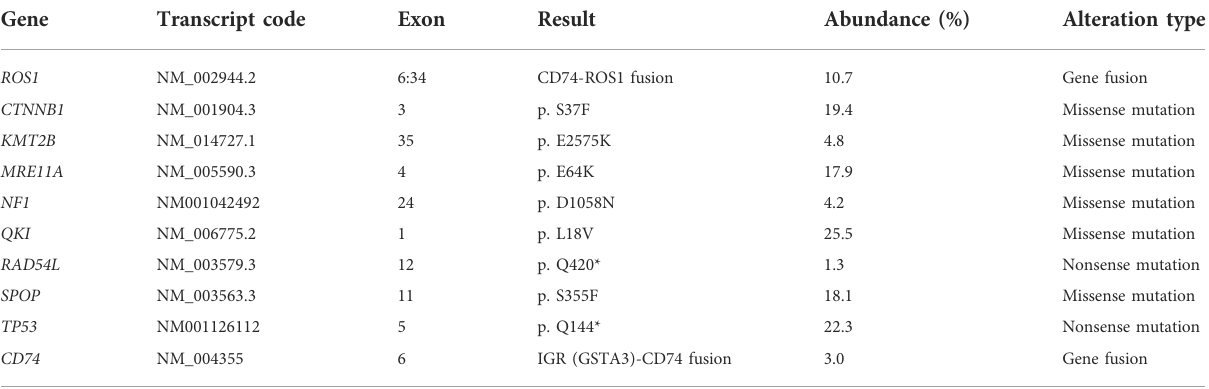
TABLE 1 Summary of genomic alterations tested via next-generation